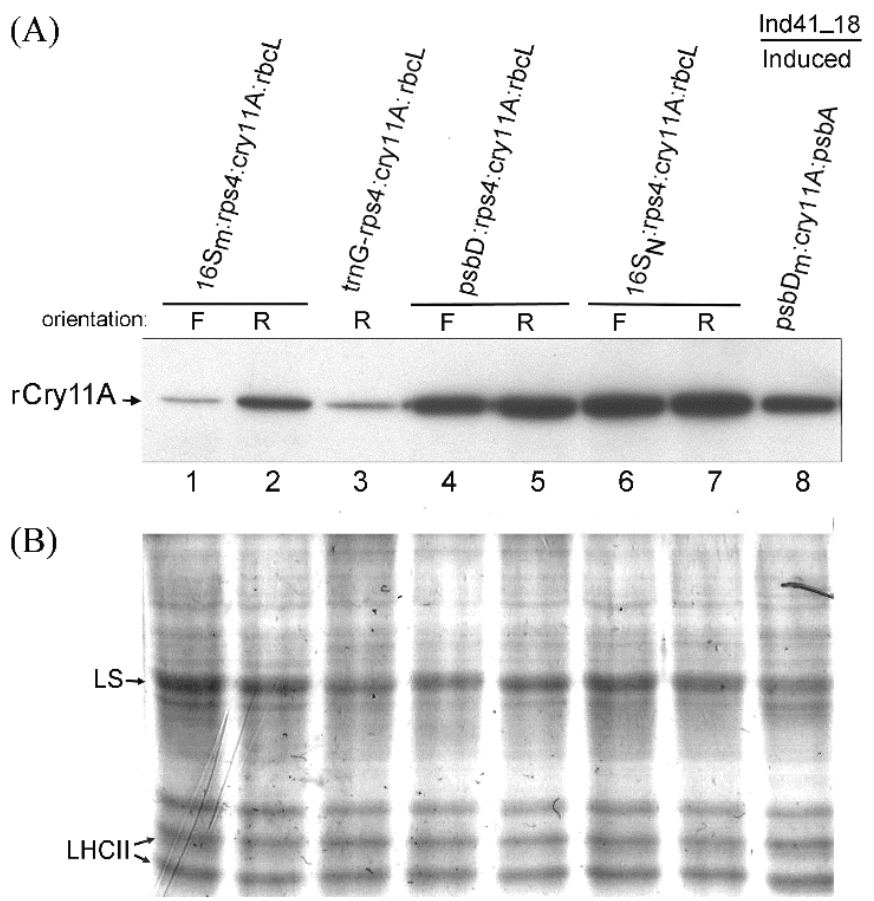
Figure 4. Western blot analysis of expression of the rps4:cry11A:rbcL -based transgenes with different promoters. The indicated transgene constructs were introduced into CC-373 in both orientations, except trnG-rps4:cry11A:rbcL , which was only obtained in one orientation (lane 3). Total protein (10 µg per lane) from each CC-373 transformant and from the induced Ind41_18/ psbD m :cry11A:psbA strain was electrophoresed on two identical mini-gels of 10% polyacrylamide, one of which was blotted ( A ) and the other stained with Coomassie blue ( B ). The blot ( A ) was probed with the enzyme-conjugated anti-Flag antibody to detect the 73-kDa rCry11A protein. Some major chloroplast proteins, LS (large subunit of ribulose-bisphophate carboxylase) and LHCII (light-harvesting complex II) are indicated next to the Coomassie-stained gel ( B ).